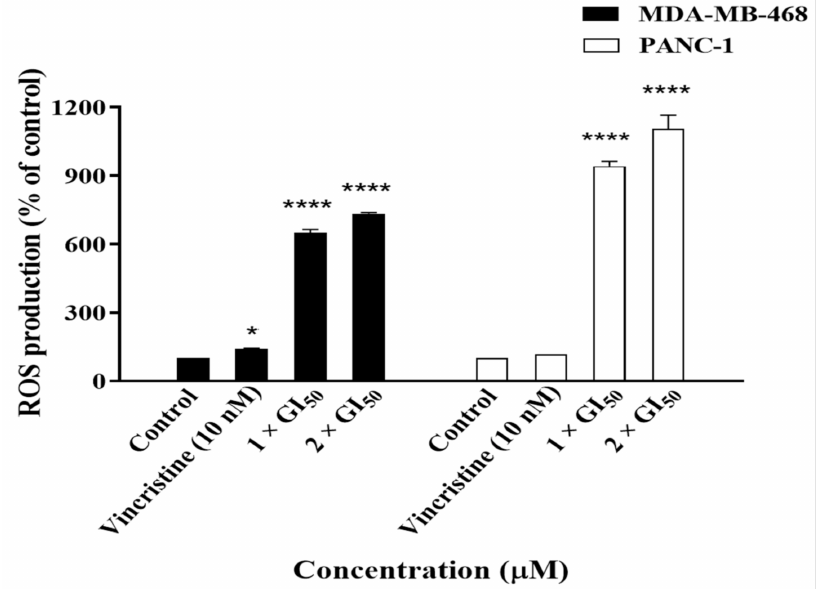
Figure 11. ROS production in MDA-MB-468 and PANC-1 cells after 24 h of treatment with Vincristine (10 nM) and 19 at concentrations of 1 × GI 50 and 2 × GI 50 . The experiment was repeated at least three times. Bars and error bars refer to the mean ± SD. * p < 0.05 vs. control, **** p < 0.0001 vs.